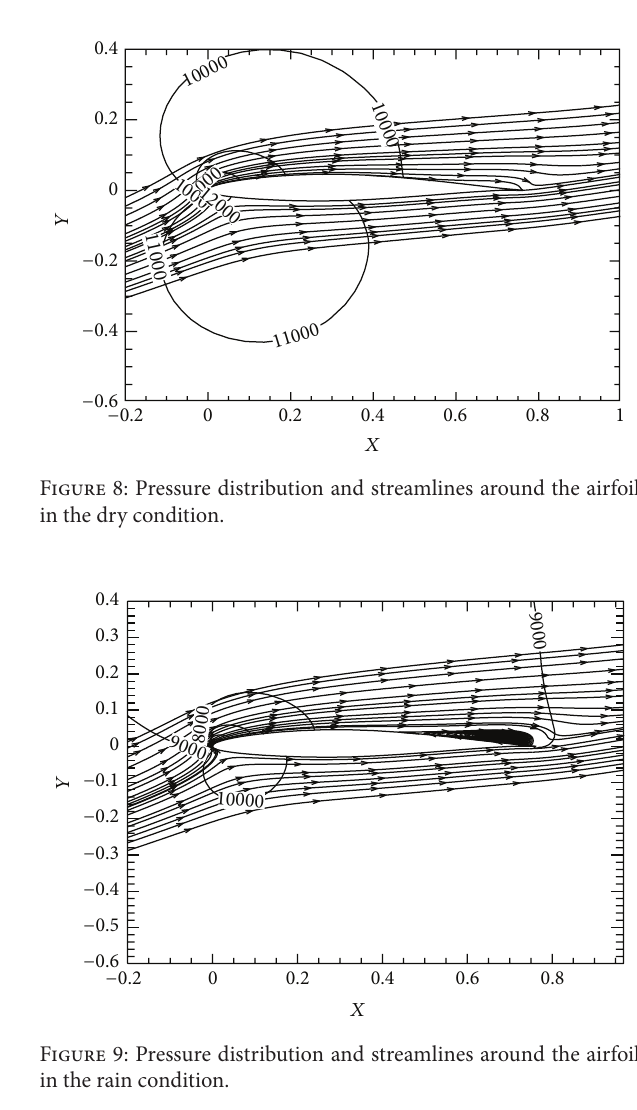
Figure 7: Drag coefficient versus AOA for numerical and experi- mental results.